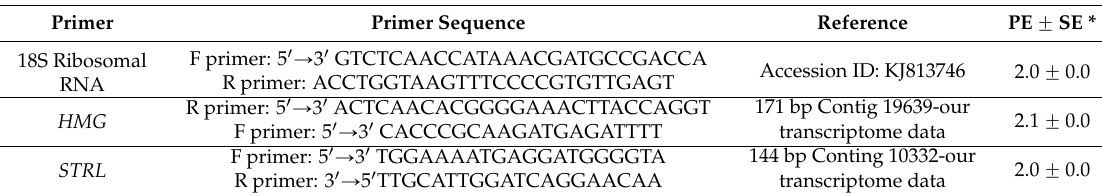
Table 2. Effect of methyl jasmonate (MeJA) treatments on diosgenin content (%) in fenugreek ( Trigonella foeum-graecum L.) varieties.